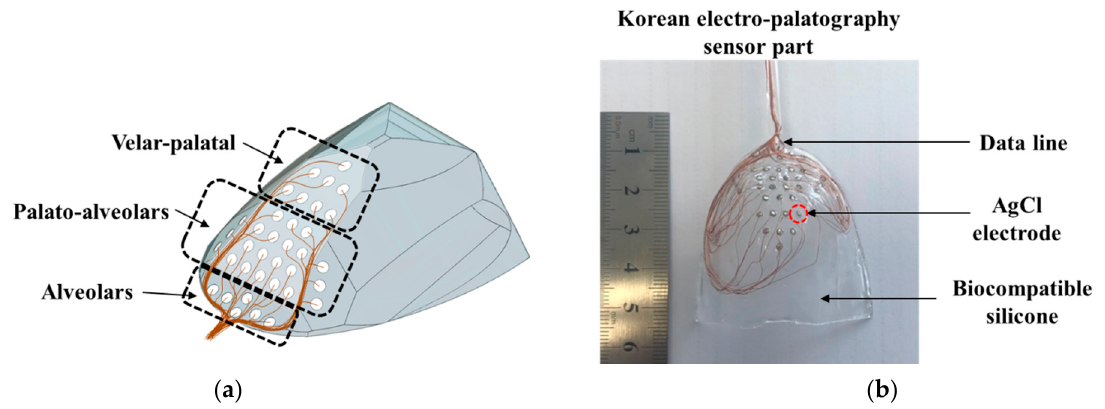
Figure 2. ( a ) The schematic and ( b ) a picture of the fabricated Korean-electropalatography